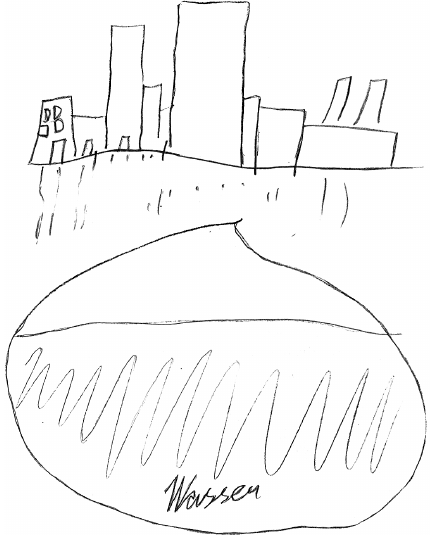
Figure 6. Examples for the categories of analysis. Groundwater in holes or